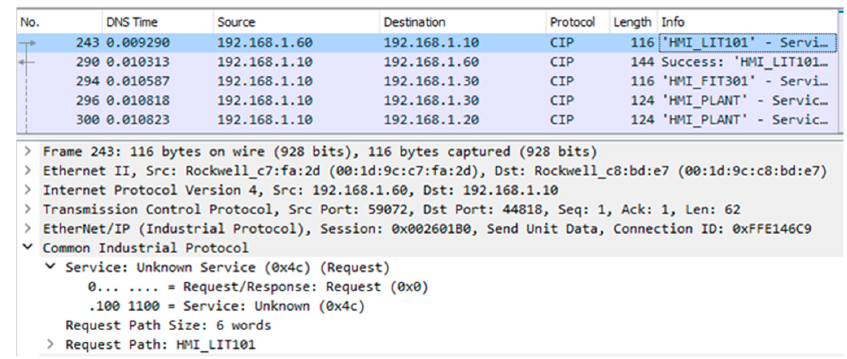
Figure 8. Request packet in CIP protocol.